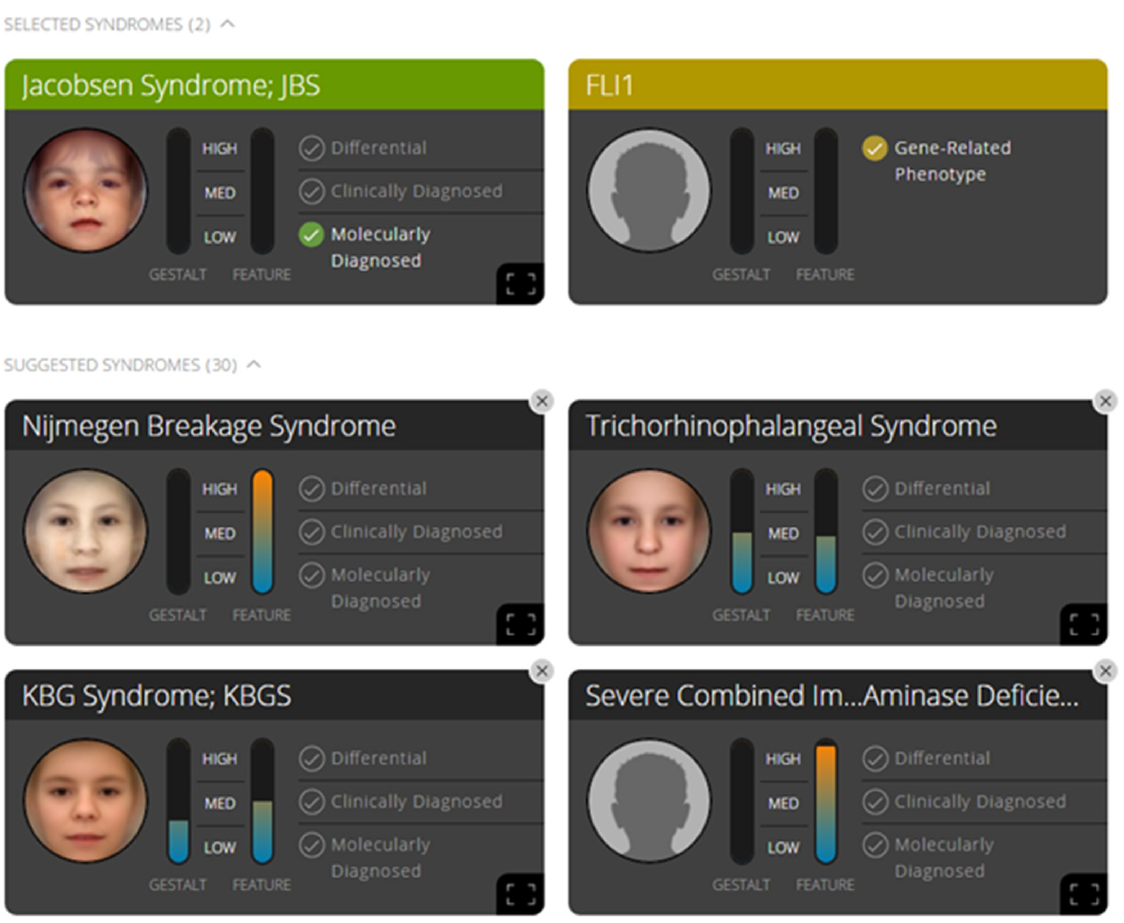
Figure 1. Prediction of the Face2Gene software, after front and side photographs of the patient were uploaded, was Nijmegen breakage syndrome (NBS, OMIM 251260) phenotype. Even though the molecular diagnosis of JBS was included, the facial analysis did not match with JBS.